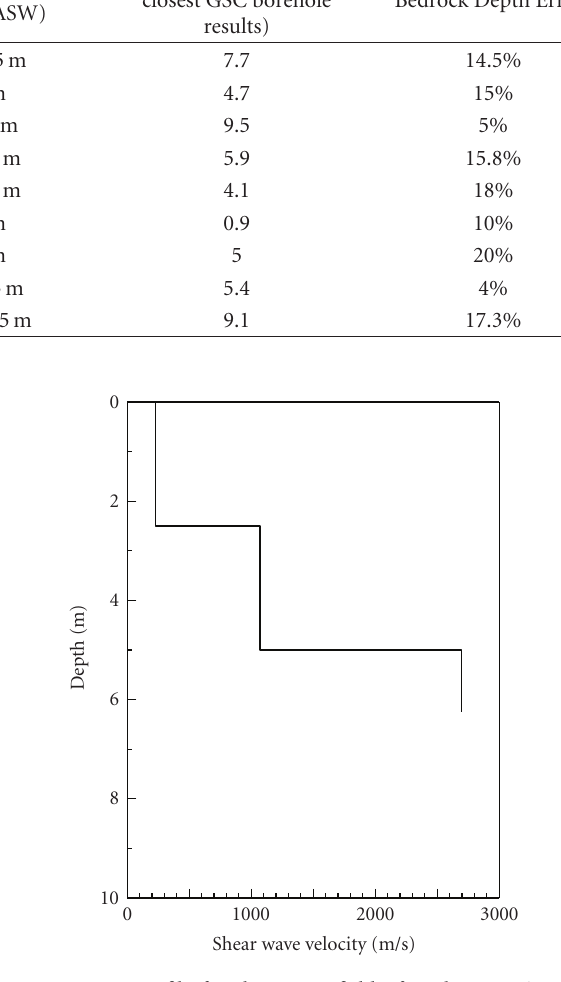
Figure 14: V s profile for the soccer field of Carleton University, based on random search inversion. The great velocity jump is obvious at the depth of 5